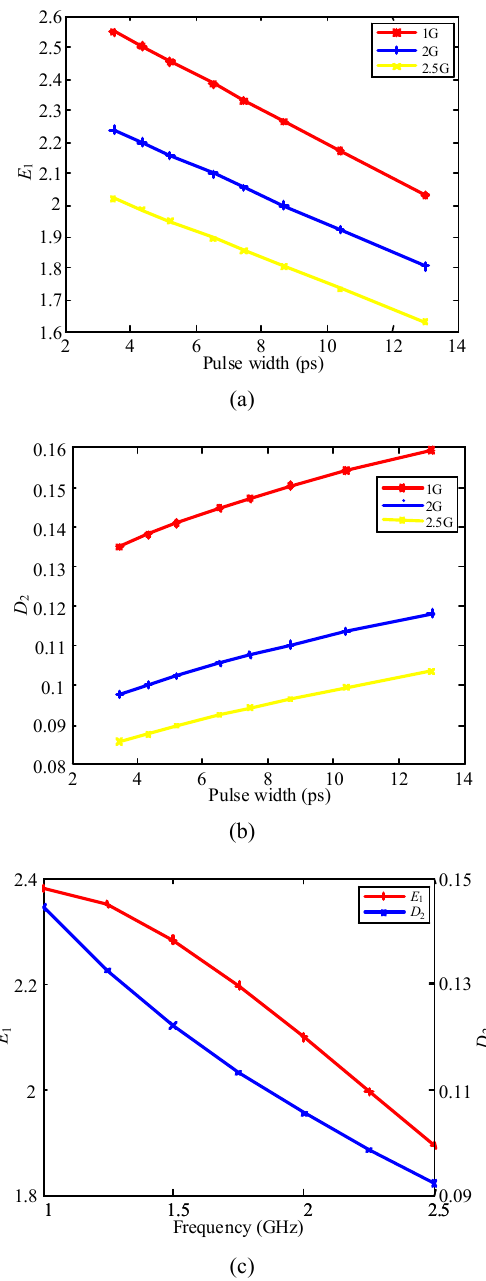
Fig. 6 Sampling linearity and efficiency: (a) E 1 of different pulse widths, (b) D 2 of different pulse widths, and (c) E 1 and D 2 of different frequencies. correlation coefficient is near 0.99999. Figure 6(c) shows the corresponding value curves of E